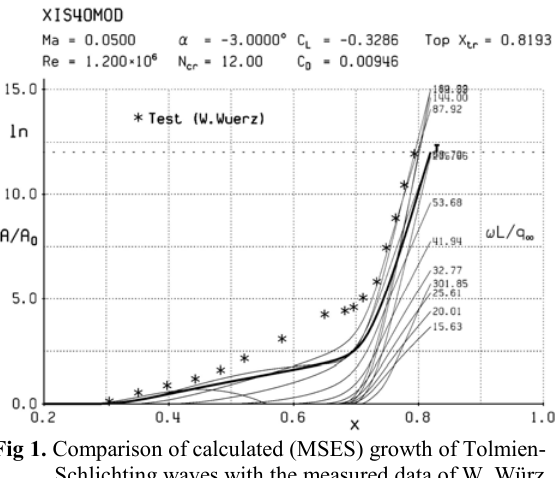
Fig 1. Comparison of calculated (MSES) growth of Tolmien- Schlichting waves with the measured data of W. Würz [9] in the laminar separation bubble. The thick line corresponds to the simplified envelope method